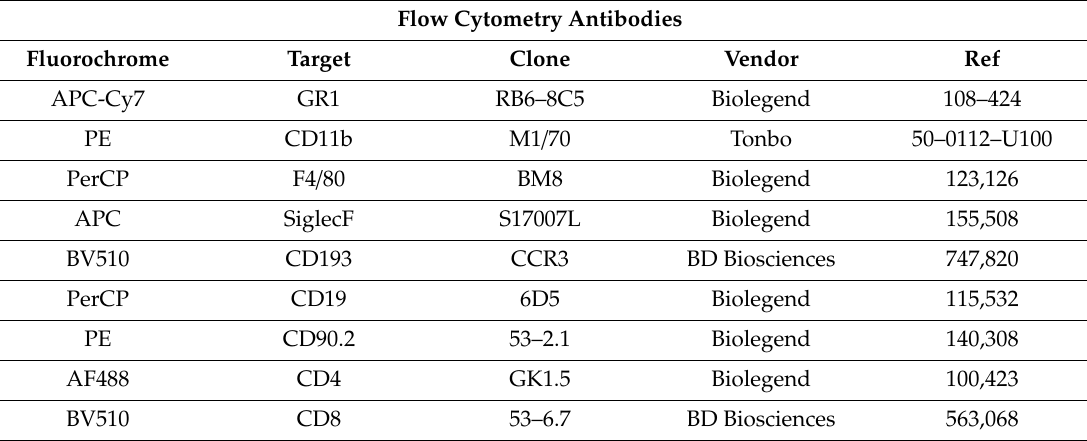
Table 1. List of antibodies for flow cytometry.